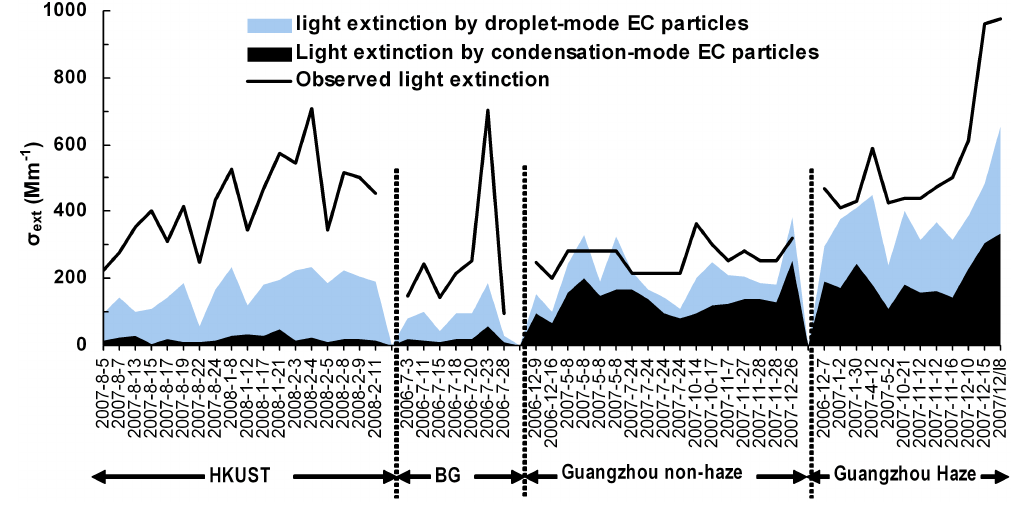
Fig. 5. Contributions of droplet-mode and condensation-mode EC-containing particles to the observed light extinction at a few selected urban, suburban and rural locations in the Pearl River Delta region.